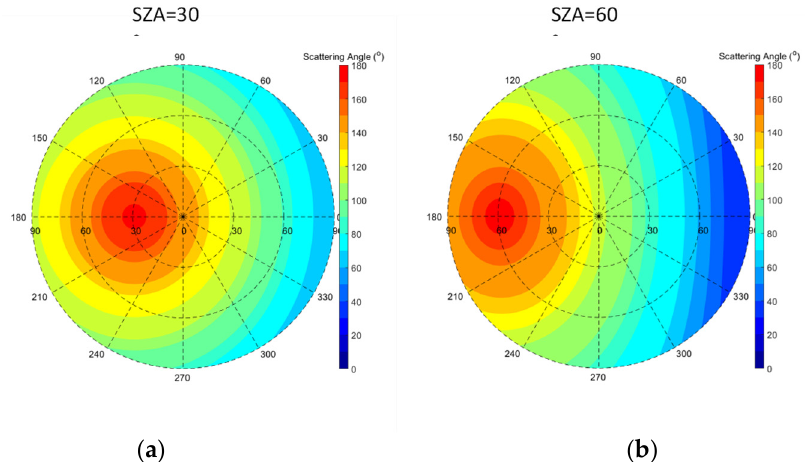
Figure 8. Distribution of scattering angles of atmospheric particles observed by instruments at different sun zenith angles (SZA) for ( a ) 30 ◦ and ( b ) 60 ◦ . The radial direction represents the view zenith angle (VZA), while the circumferential direction indicates the relative azimuth angle (RAA).